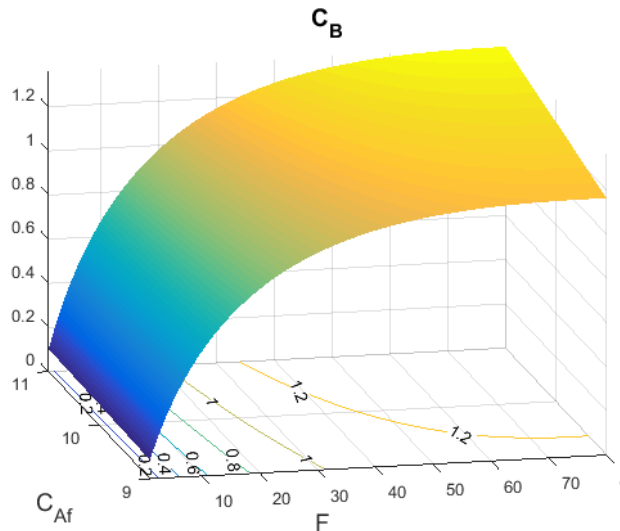
Figure 1. Steady–state characteristic of the control